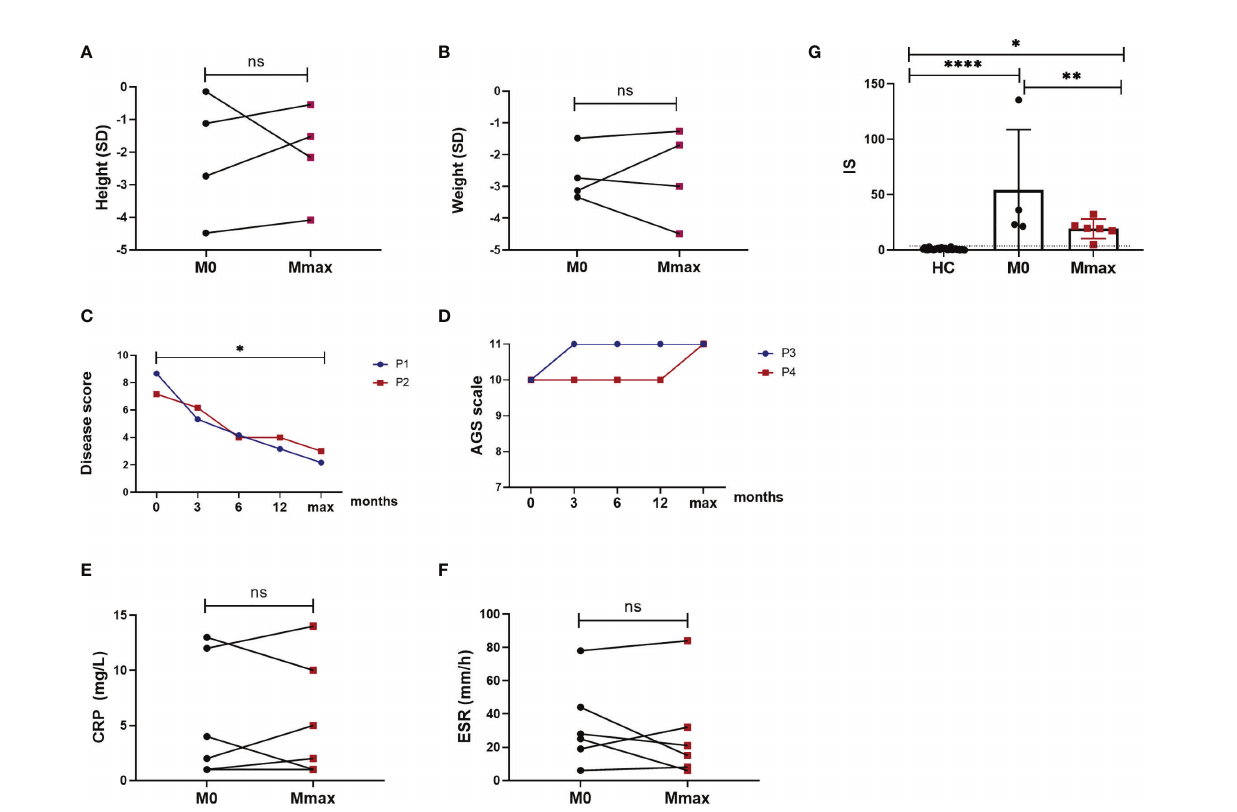
FIGURE 3 | Response to jakinib treatment. Height in standard deviation (SD) (A) showing catch-up growth in 3 patients and further failure to thrive in 1 patient (ns). Weight (B) in SD showing weight gain in 2 patients and further growth failure in 2 patients (ns). Disease score of 2 patients with SAVI improved after the treatment ( p < 0.05) (C) . AGS scale elevated and stayed stable during the treatment in patient 3 and patient 4 (D) . Measures of CRP (E) and ESR (F) showing no improvement after the treatment (ns). Six gene-based IFN score (G) decreased after the treatment ( p < 0.01). The dotted line indicates the cutoff value (2.56). HC, healthy control; M0, the time before jakinib treatment; Mmax, the time at the last follow-up visit; P, patient; * p < 0.05; ** p < 0.01; **** p < 0.0001; ns, nonsigni fi